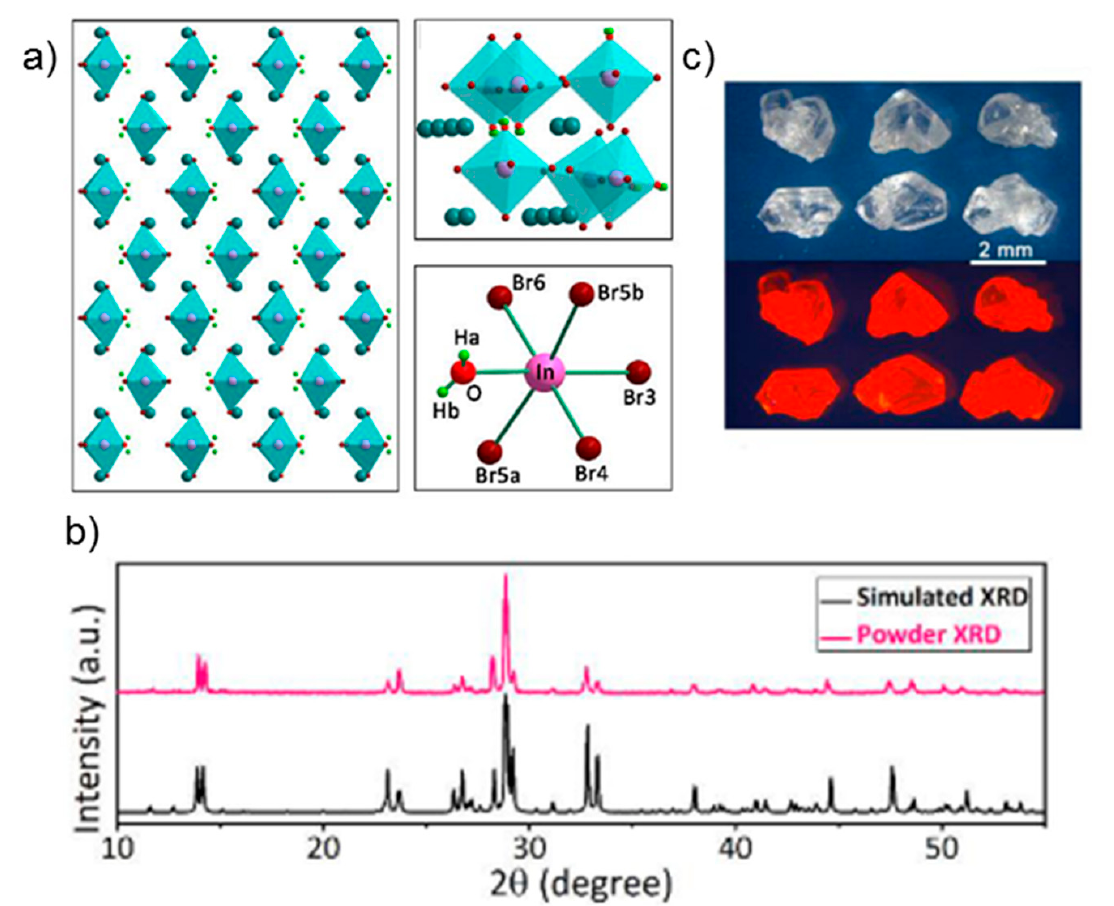
Figure 2. ( a ) Crystal structure of Cs 2 InBr 5 · H 2 O viewed along the (001) axis (cyan: Cs, brown: Br, pink: In, red: O, green: H). ( b ) SCXRD and PXRD patterns of Cs 2 InBr 5 · H 2 O. ( c ) Images of Cs 2 InBr 5 · H 2 O single crystal under ambient light (up) and UV light (bottom). Reprinted/adapted with permission from Ref. [39]. Copyright © 2022 Wiley-VCH Verlag GmbH & Co. KGaA, Weinheim.